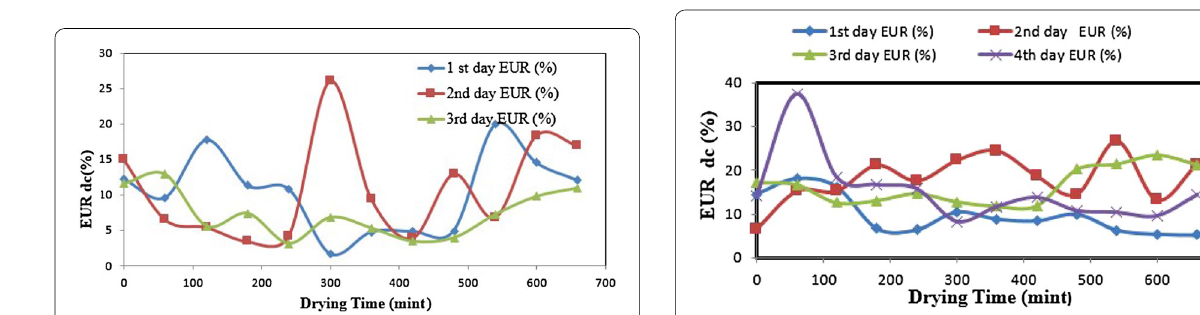
Fig. 1 Variation of energy utilization ratio in drying chamber as a function of drying time of tomato